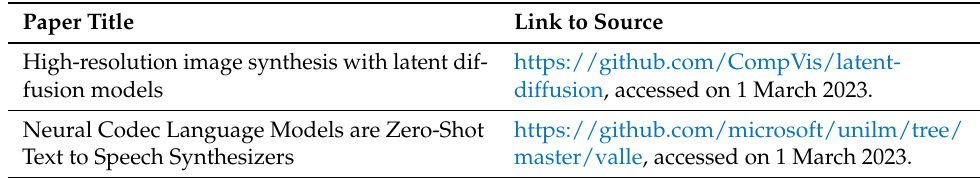
Table 10. Source code links for Generative